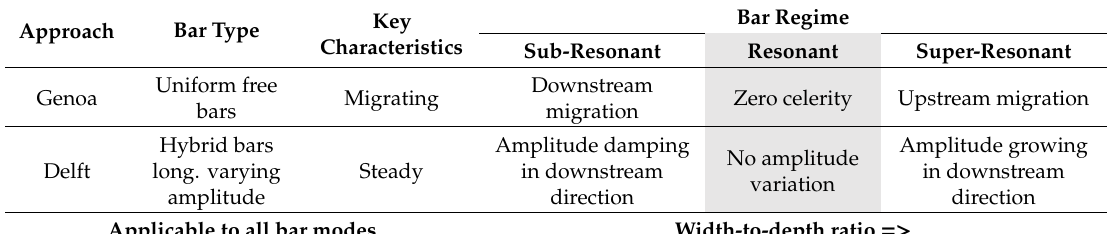
Table 1. Approaches in bar